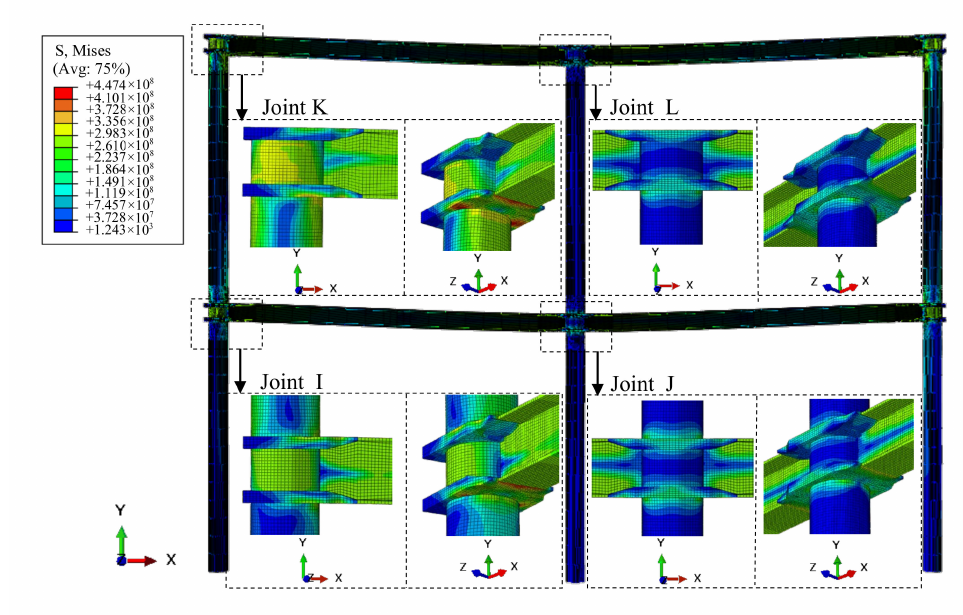
Figure 9. Mises stress of model B c when the vertical displacement of the interior column reached its maximum value under load